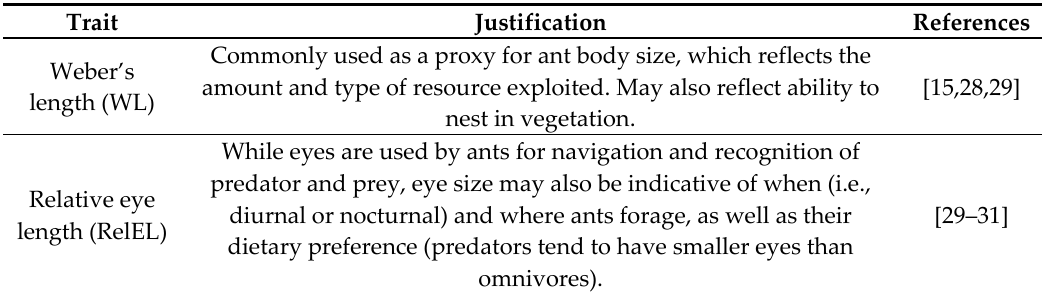
Table 1. Morphological traits used for functional diversity